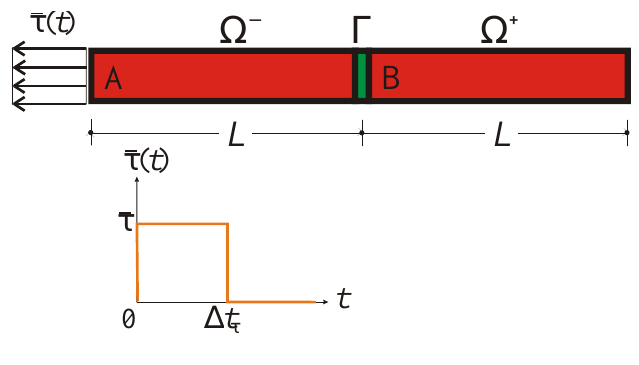
Figure 4. Longitudinal wave propagation in a two-phase rod: sketch of geometry and load- ing condition.